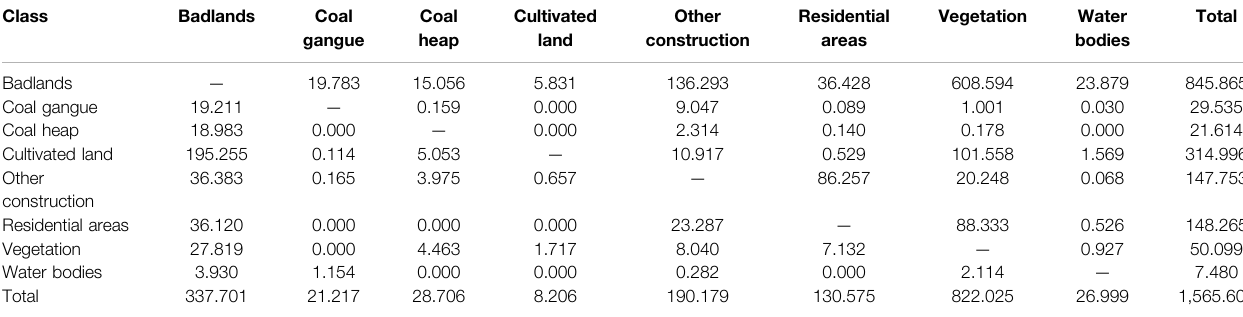
TABLE 9 | Land-use class change matrix from 2003 to 2011 (unit: 10 – 2 km 2 ). Class